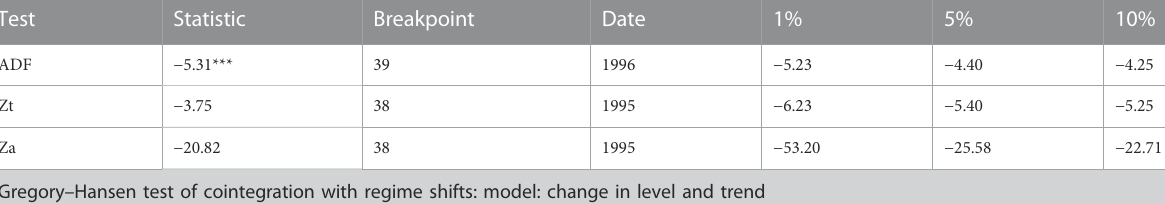
TABLE 10 Gregory – Hansen test of cointegration with regime shifts: model: change in level.